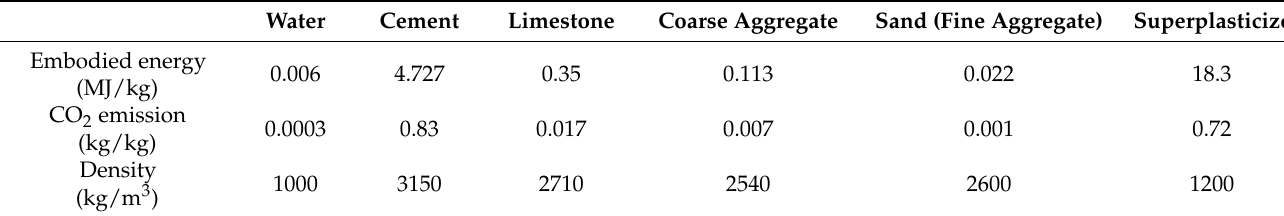
Table 1. Embodied energy, CO 2 emission, and density of constituent of concrete